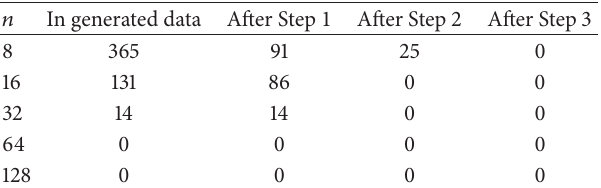
Table 4: Number of violations in generated data and after each of the steps of the proposed